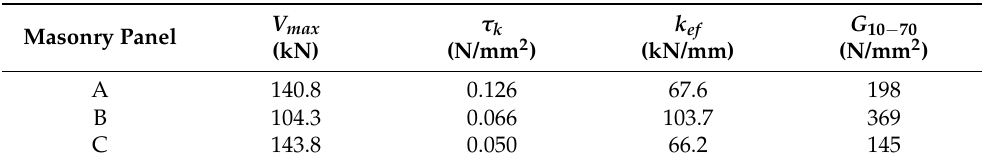
Table 4. Experimental values of the ultimate shear force V max , the shear strength τ k , the effective stiffness k ef , and the corresponding shear modulus G 10 − 70